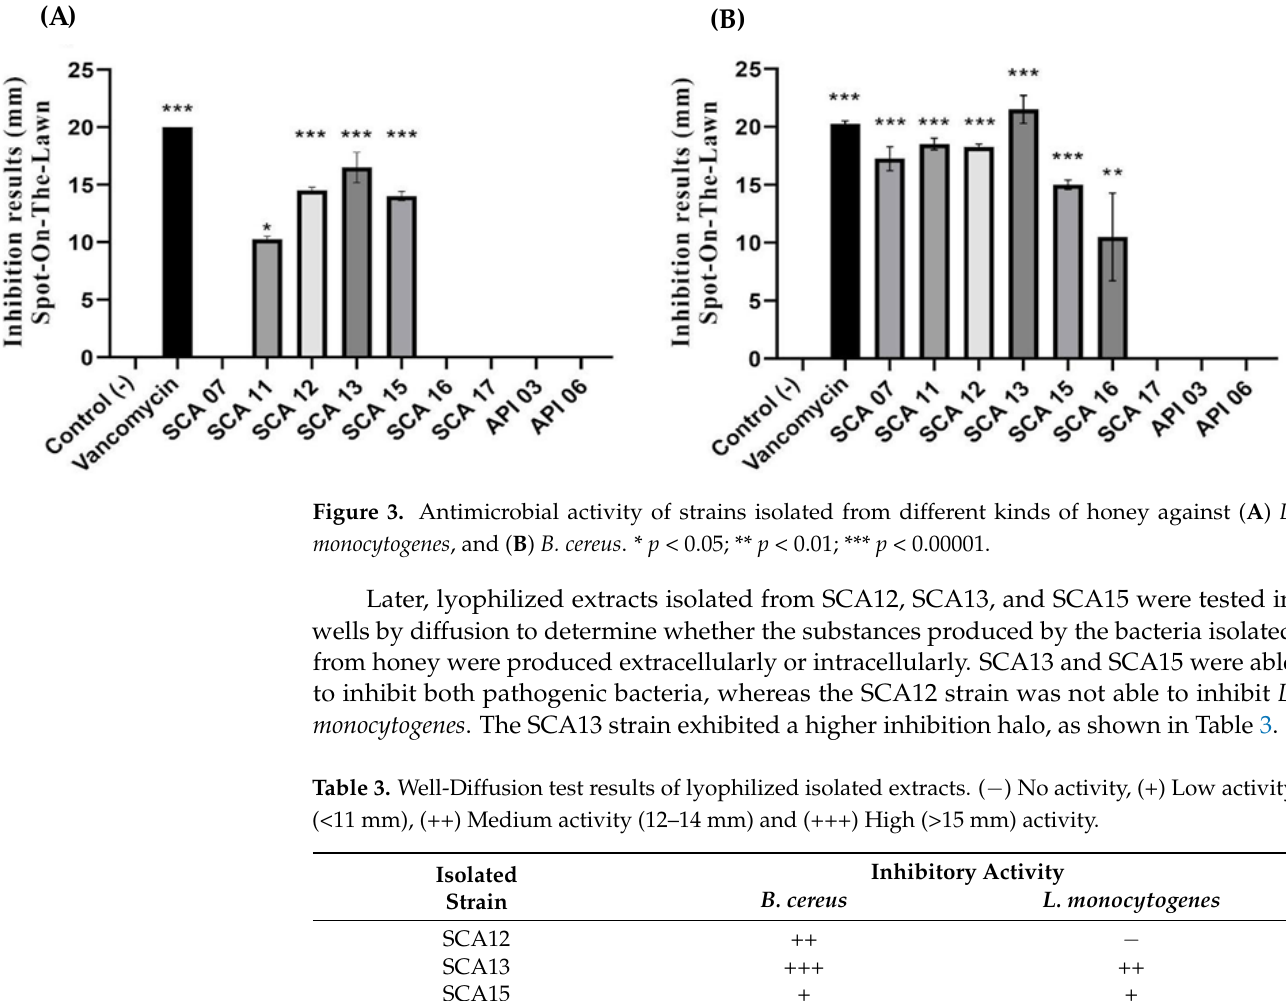
tor bacterium, L. monocytogenes.